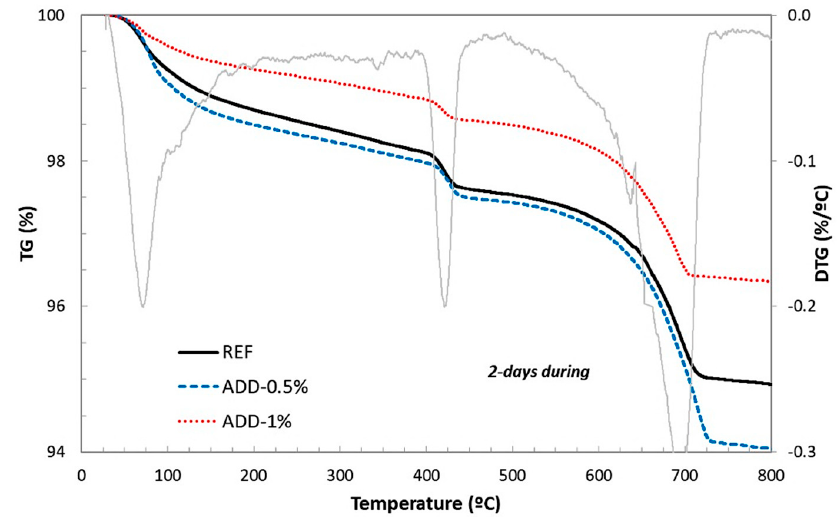
Figure 10. Thermogravimetric analyses of specimens of the studied mortars after 2 days curing in high-humidity conditions (98% relative humidity).